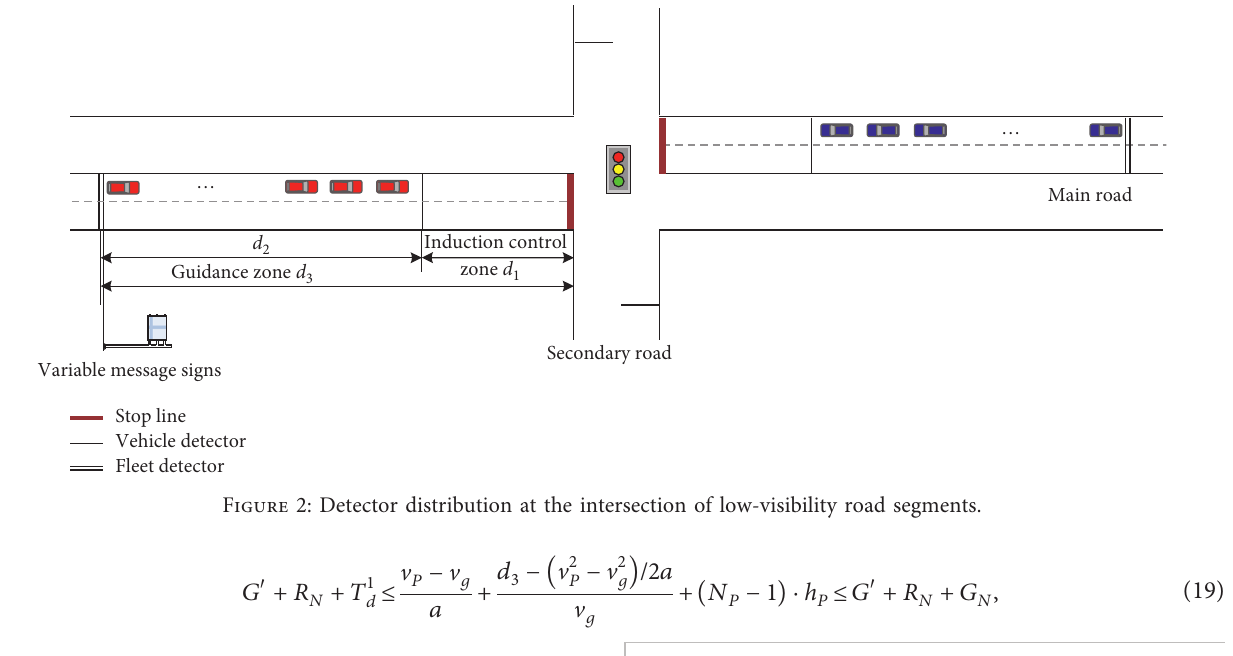
Figure 2: Detector distribution at the intersection of low-visibility road